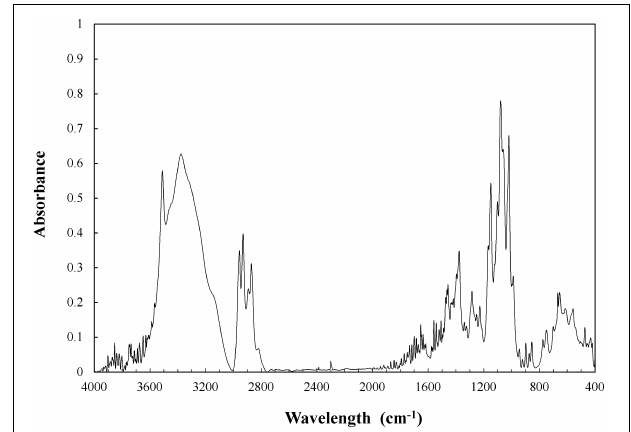
FIGURE 4 | FT-IR spectrum for butyl- β -galactoside. Conditions: KBr pellet, 298 K and atmospheric